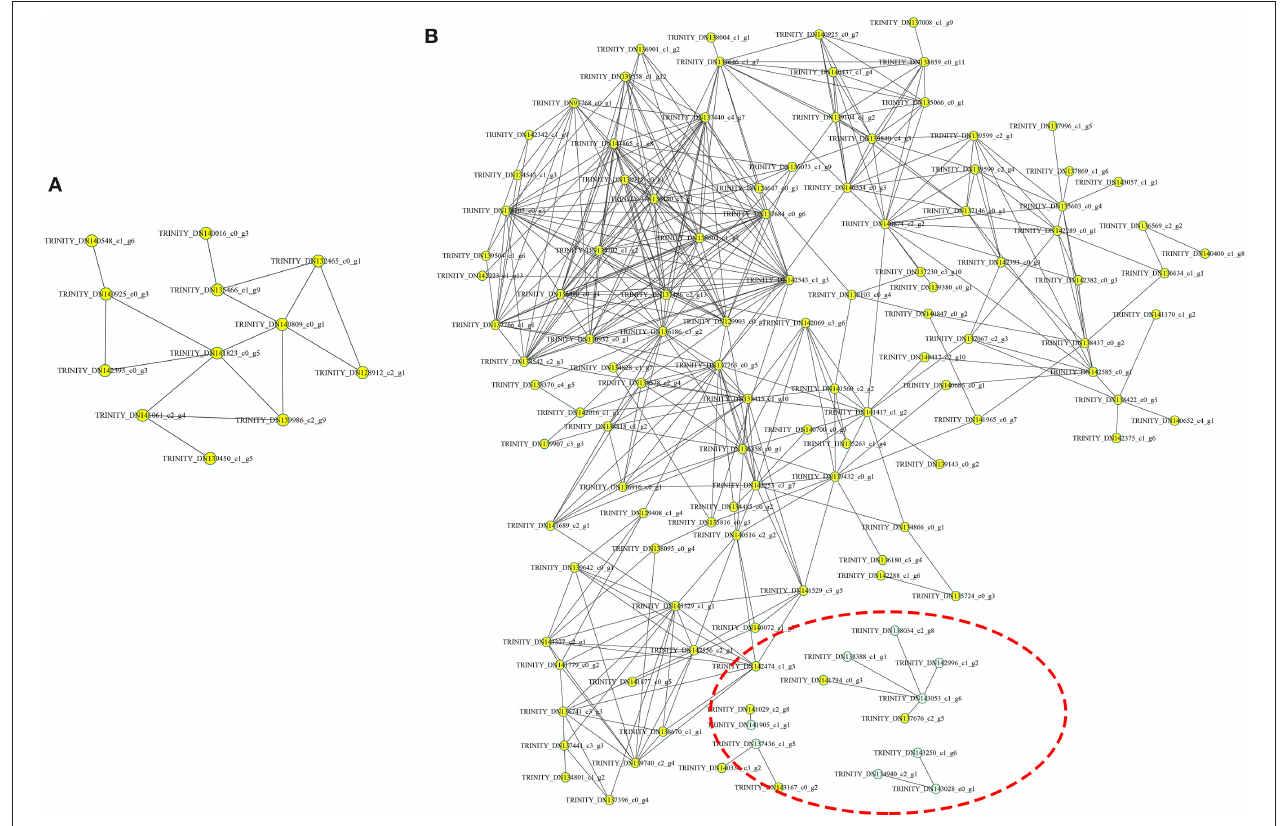
FIGURE 7 | Analysis of the functional network by STRING 9.0 of DAPs. (A) The functional network in the HR_UR group. (B) The functional network in the FR_HR group. The green circles inside the red dotted line represent proteins that may interact with each other in cell wall and stress response